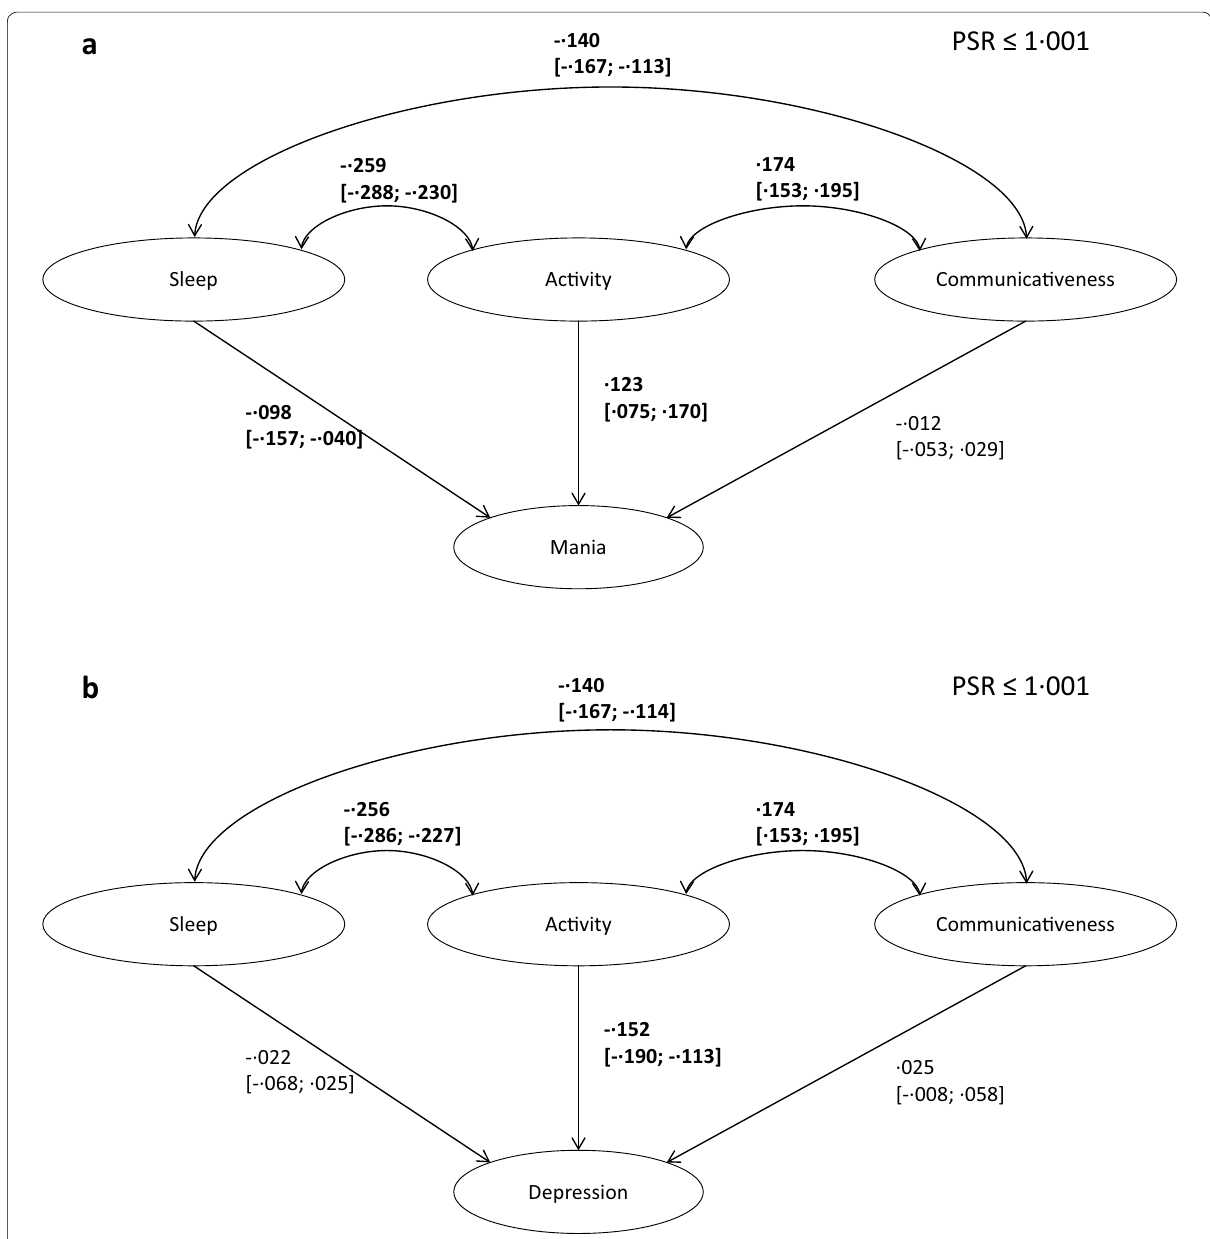
Fig. 3 Structural model linking within‑person fluctuations in mania ( a ) and depression ( b ) to within‑person fluctuations in sleep, activity, and communicativeness. Figure depicts standardized estimates (with associated 95% credible intervals in square brackets). Note that only the within‑person associations are